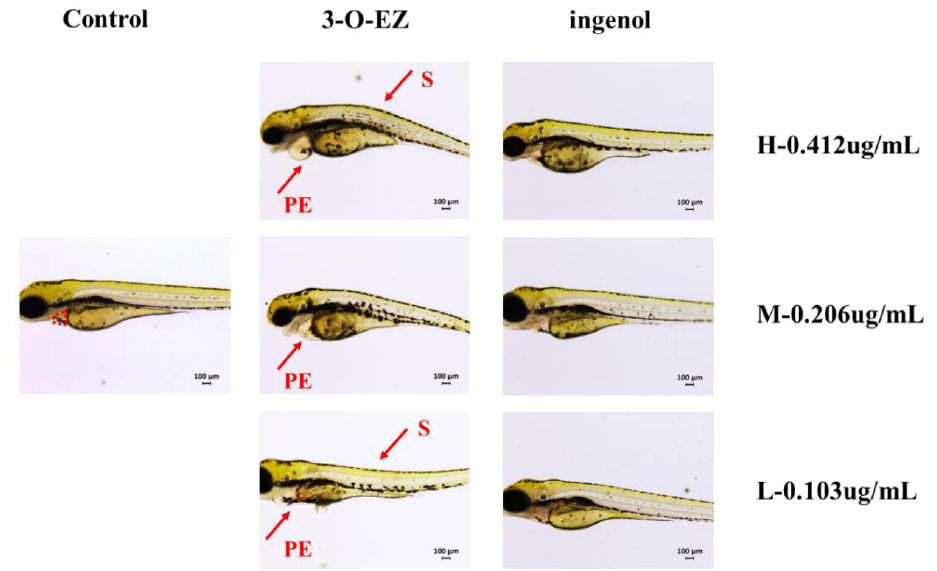
Figure 3. Abnormal embryos exposed to control, 3-O-EZ and ingenol groups. The control group was treated with the embryo medium, while the 3-O-EZ and ingenol groups were dissolved in the embryo medium with high (H, 0.412 ug / mL), moderate (M, 0.206 ug / mL) and low (L, 0.103 ug / mL) dose groups. Each treatment group showed varying degrees of pericardial edema (PE) and scoliosis